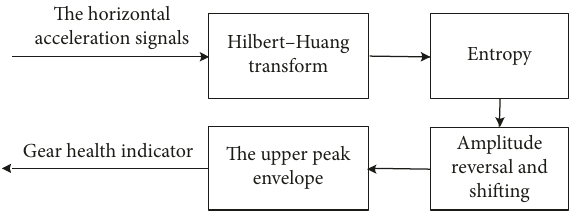
Figure 2: Hilbert–Huang